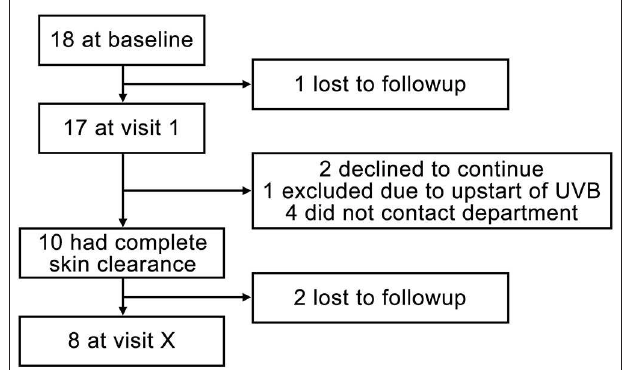
FIGURE 1 | Flowchart of included